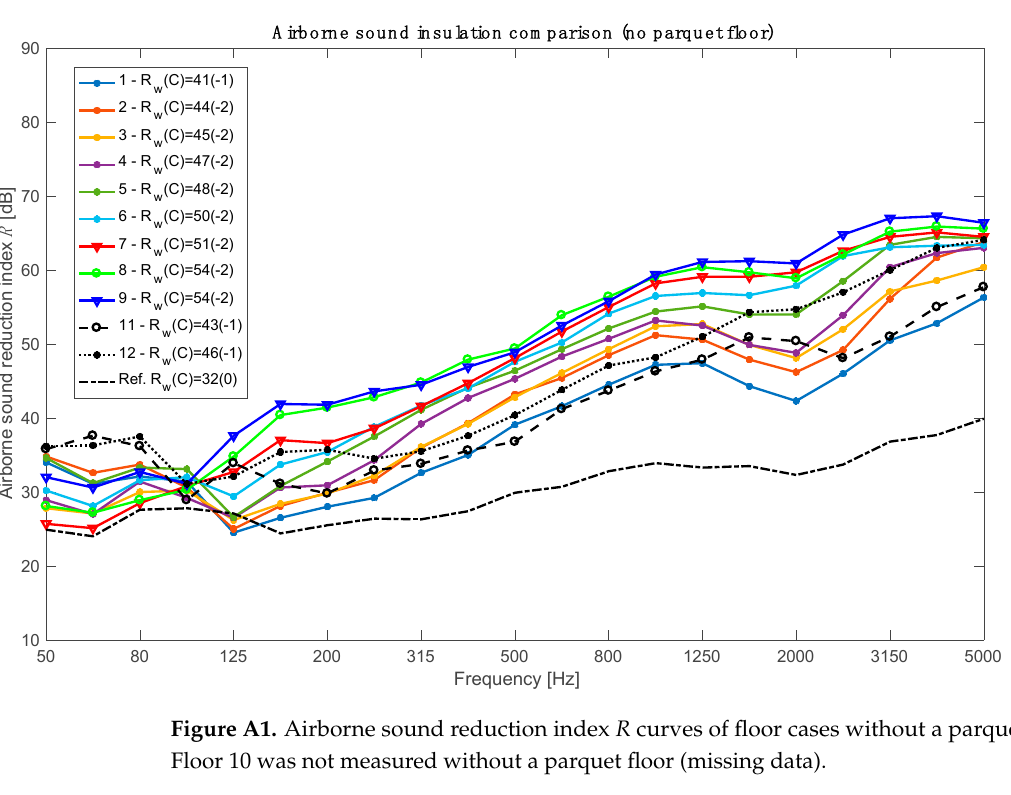
Figure A1. Airborne sound reduction index R curves of floor cases without a parquet floor on top. Floor 10 was not measured without a parquet floor (missing data).